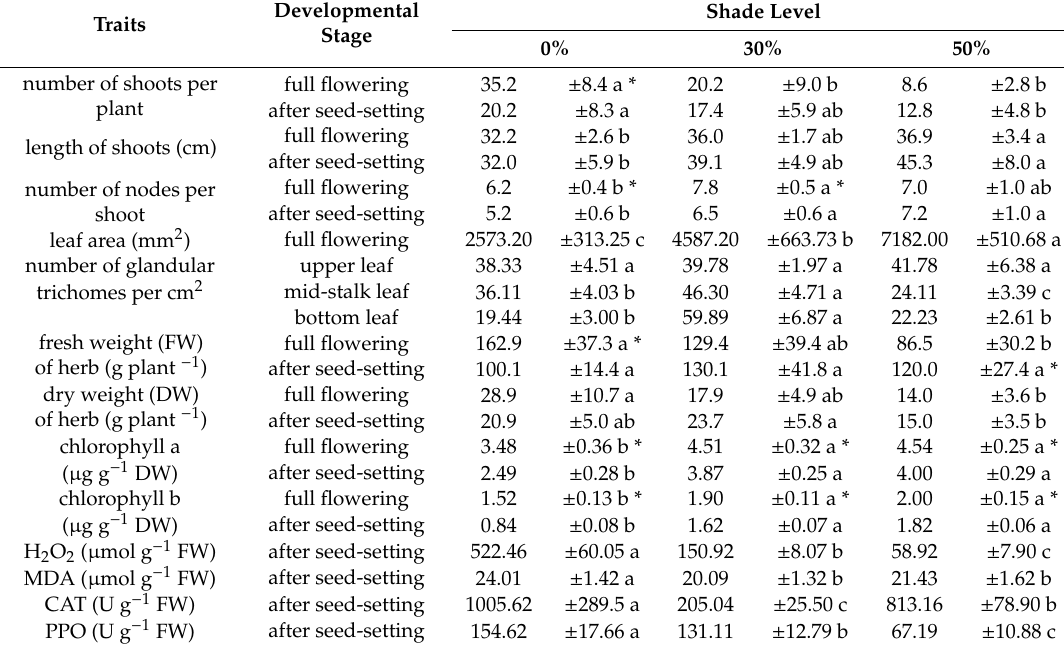
Table 3. E ff ects of plant shading on selected developmental and physiological